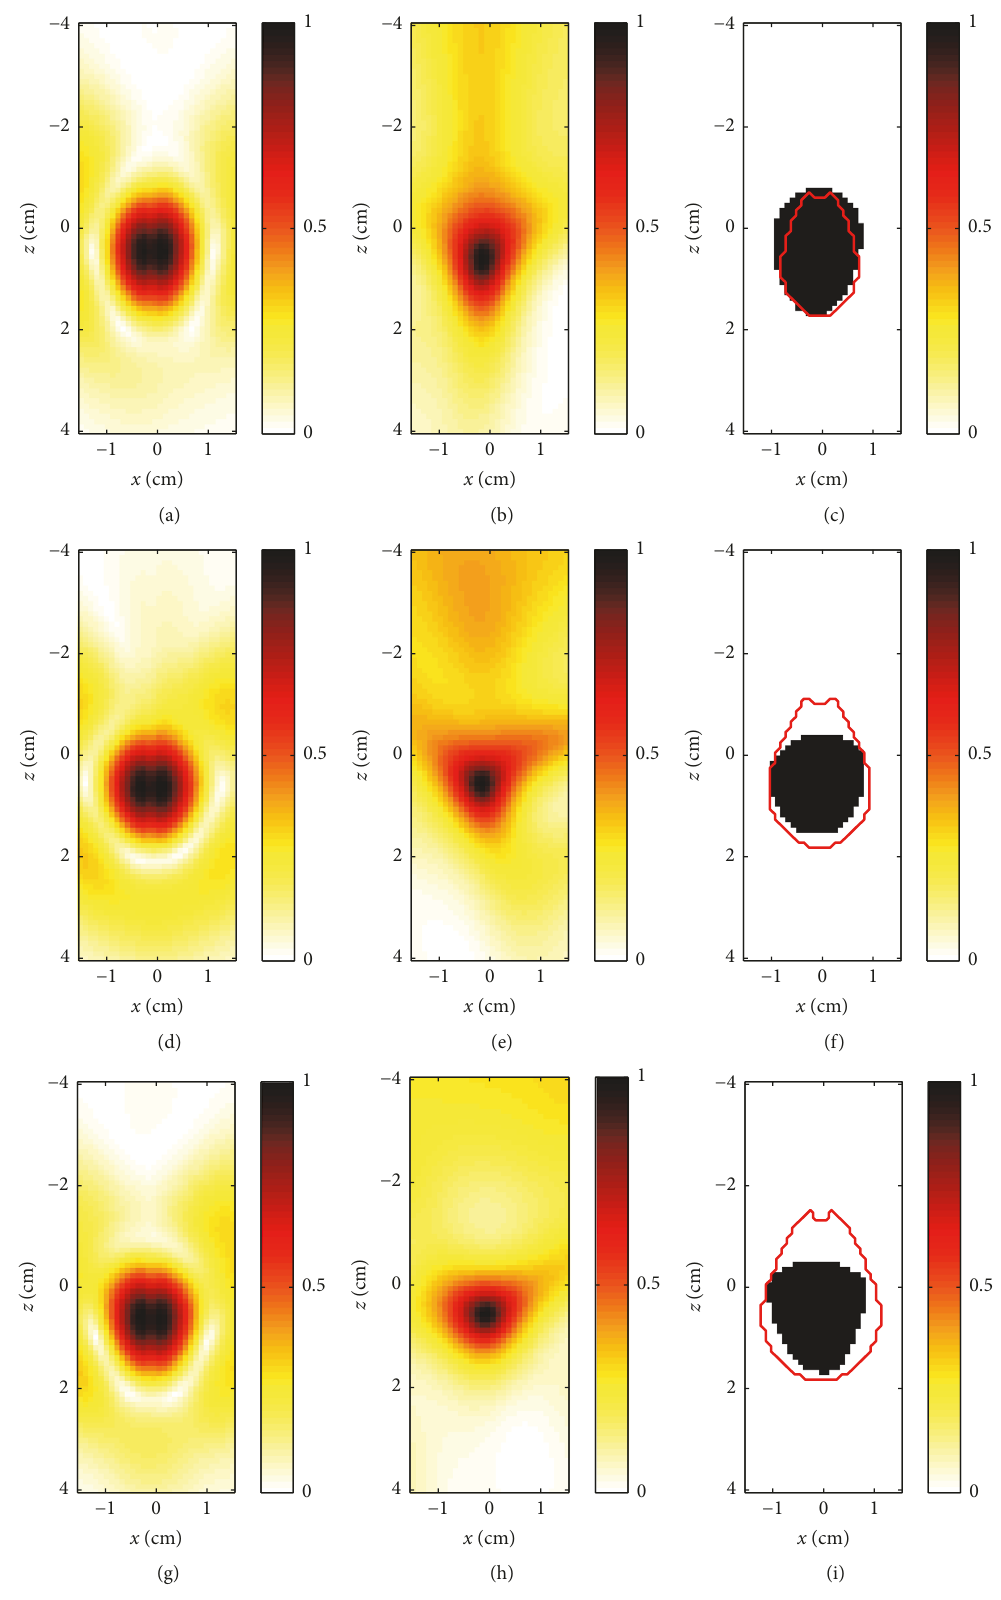
Figure 6: Reconstructions of the electric variations due to the ablation treatment for the TSVD (a, d, g) and LSM (b, e, h) algorithms and −3 dB cuts of fusion images (c, f, i), adopting a SNR equal to 80dB, at 60 s (a, b, c), 120 s (d, e, f), and 180 s (g, h, i). The shape of the actual ablated area is superimposed (red line) to the fusion